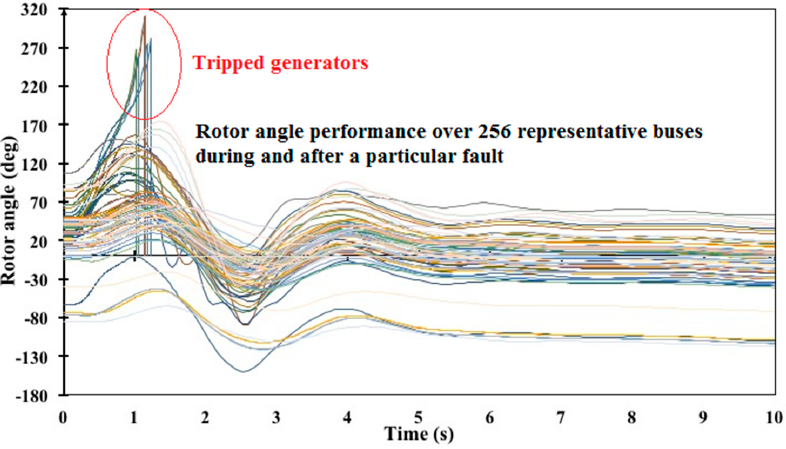
Figure 7. No system separation for dispatch SLL 1 .